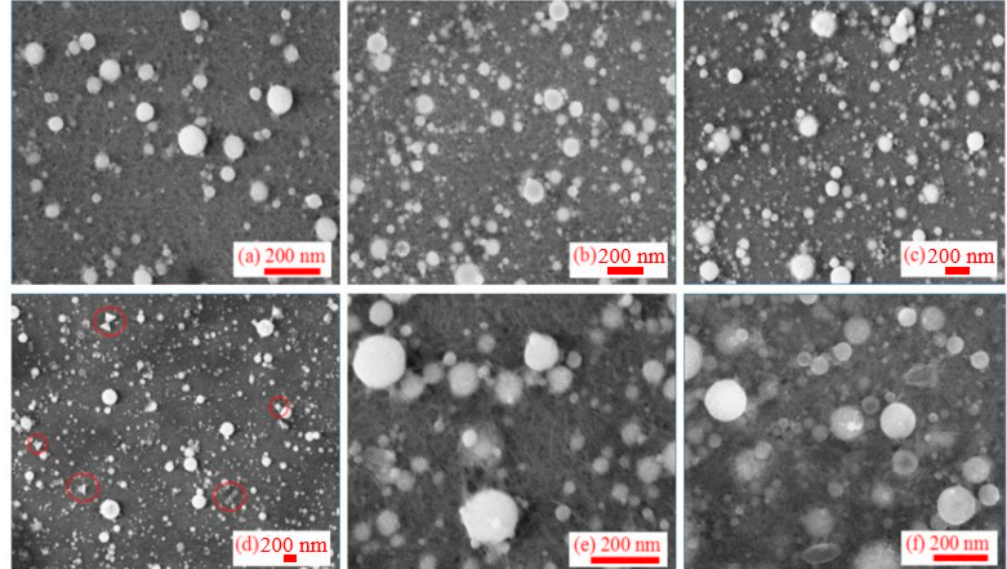
Figure 2. SEMs of the colloidal solutions synthesized using ns, 1064 nm pulses and measured at different time intervals from ablation: ( a ) Less than 1 day after ablation, ( b ) 8 days, ( c ) 15 days, ( d ) 40 days, ( e ) 60 days, and ( f ) 90 days after ablation.